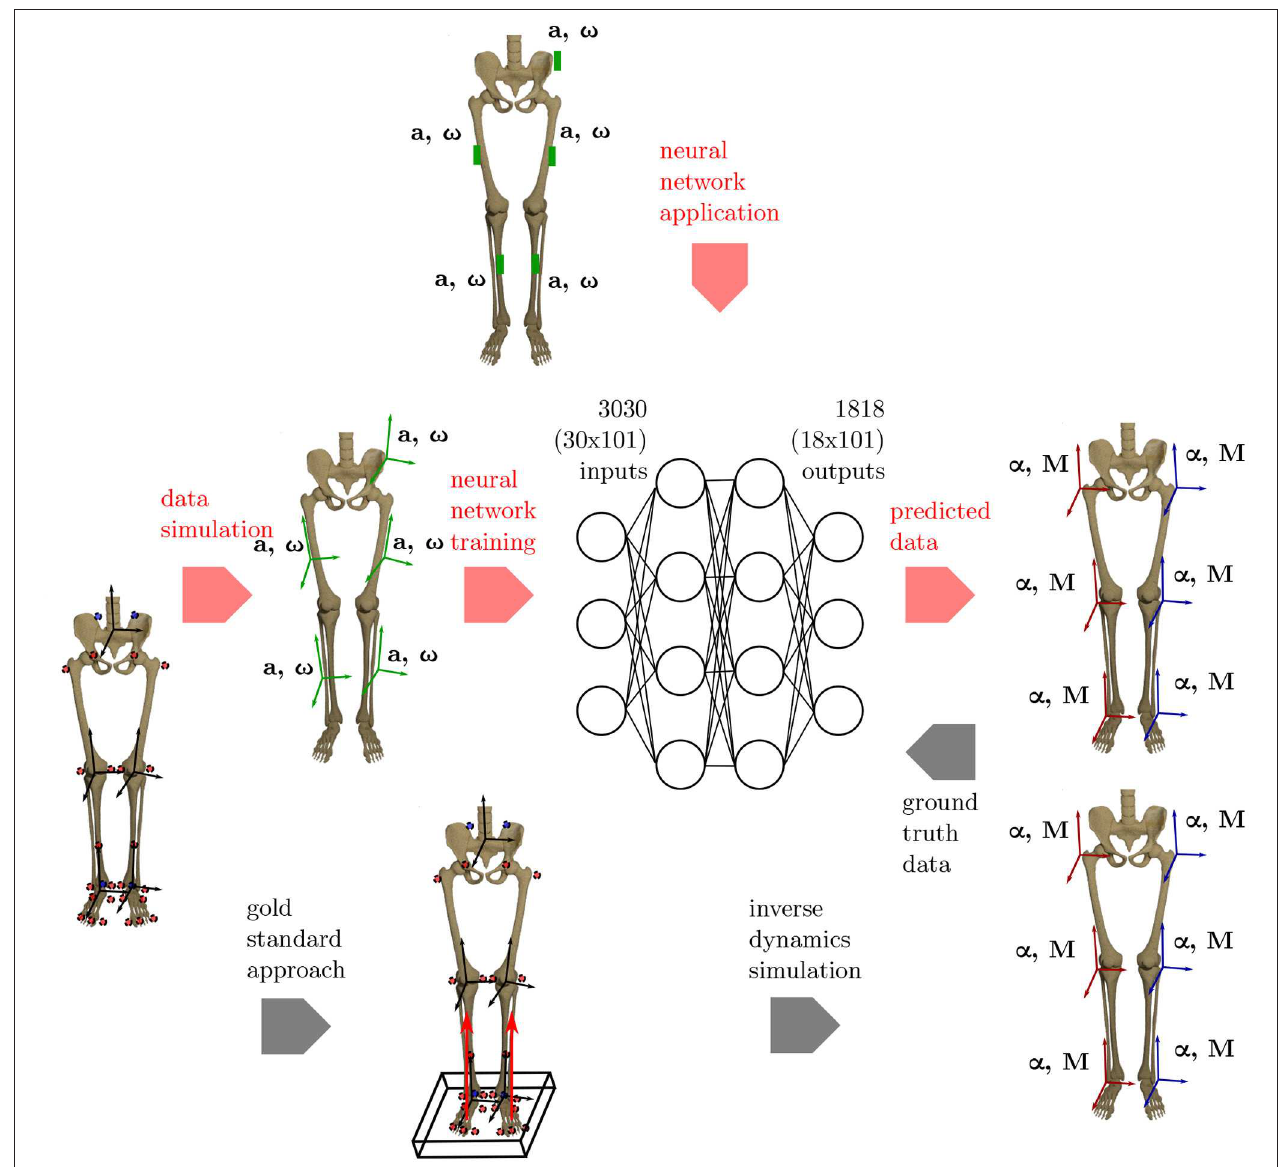
FIGURE 1 | Overview of the methods applied. To get the ground truth information on the joint angles and joint moments of the lower limbs, the gold standard approach using an optical motion capture system and force plates to collect the data is used. Based on this data, inverse dynamics simulations are undertaken to calculate the joint angles and joint moments. Using the proposed ML method, inertial data (angular rate ω and acceleration a ) is simulated from the optical data and used as inputs for an artificial neural network. Based on the ground truth joint angles and moments, the network learns the connection between the input and output data. The method is validated using an IMU system based on five sensors that are placed consistently with the simulated